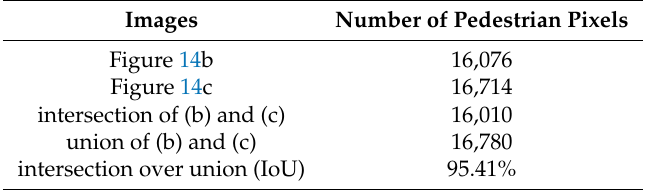
Table 8. Segmentation accuracy of depth map-based flood filling method.